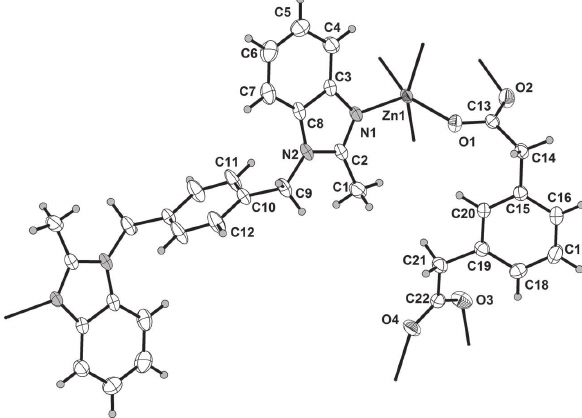
Table 1: Data collection and handling.